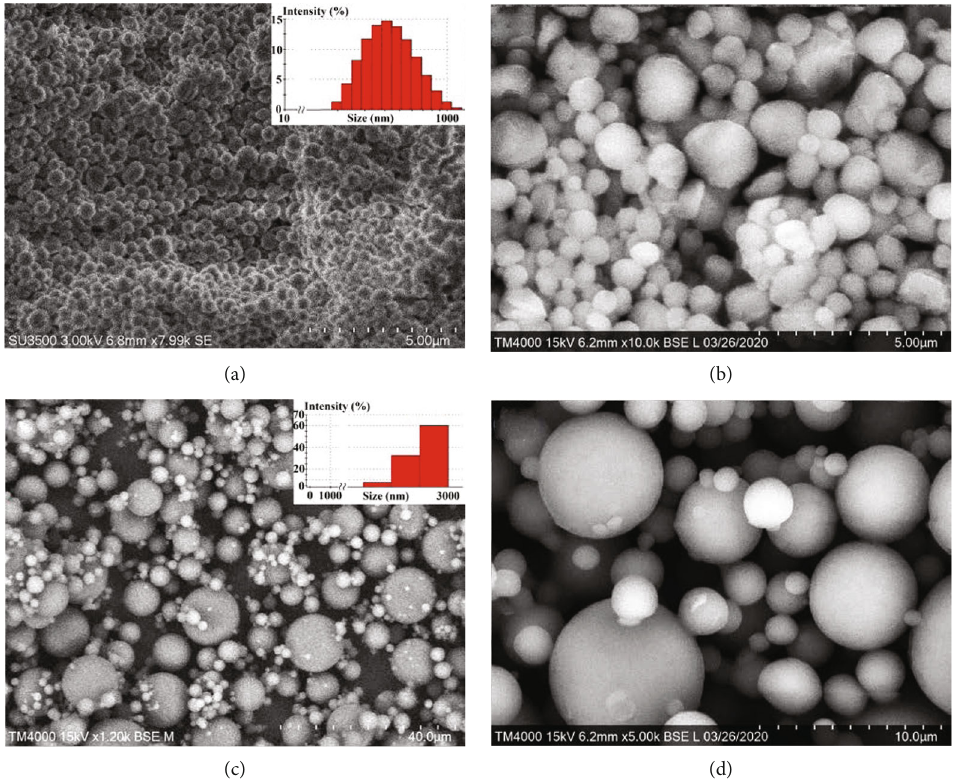
Figure 4: SEM images and size distribution of OZ-P3HB microparticles: (a) OZ-MP OZ-MP ; (d) OZ-MP sputter coated with SD SD